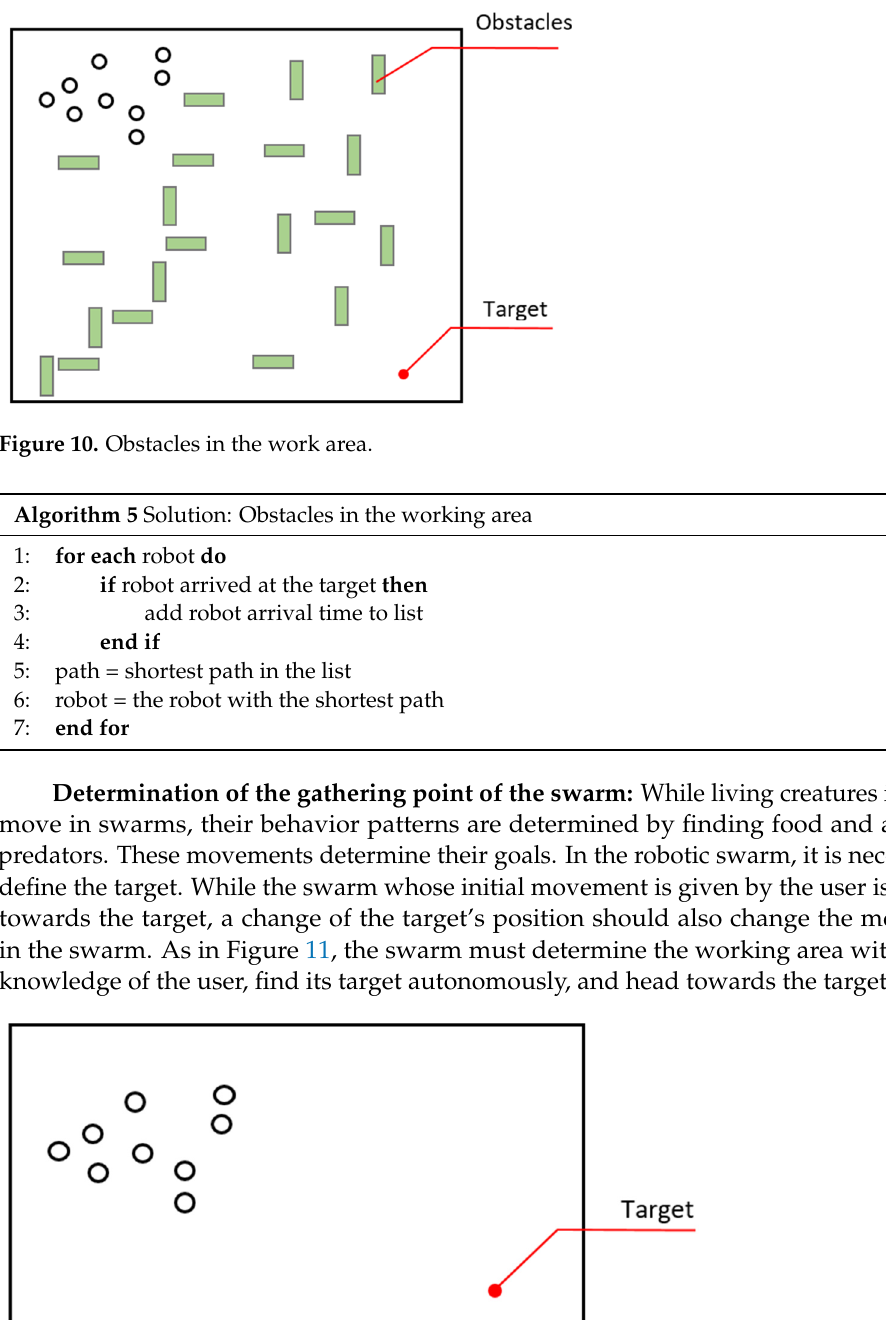
Figure 9. Inability of the individuals in the swarm to reach the target. Algorithm 4 Solution: When the target is given to the robots